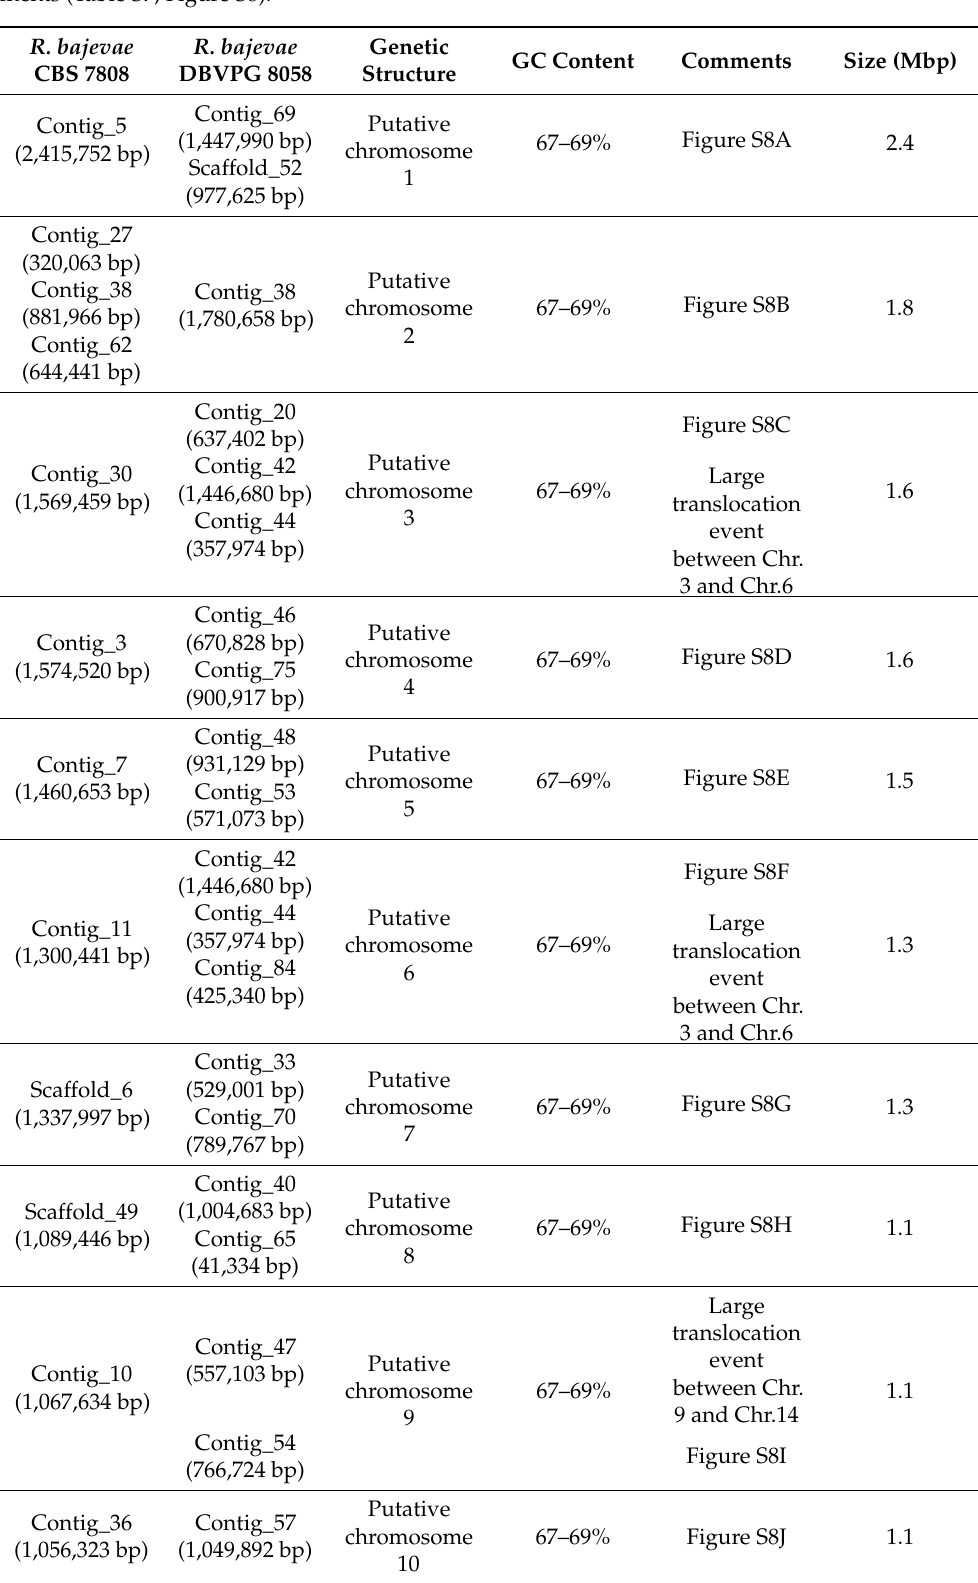
Table 2. Putative chromosomes in Rhodotorula babjevae deduced from whole genome LASTZ align- ments (Table S7, Figure